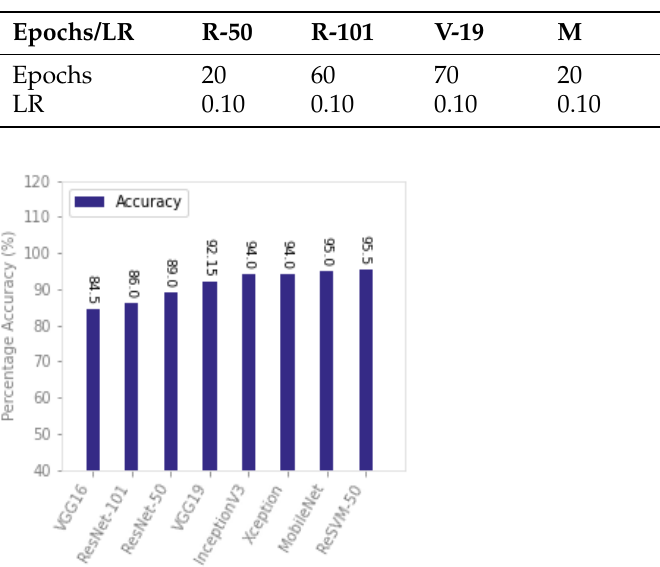
Table 3. Optimal parameters (number of epochs and learning rate) of ReSVM and state-of-the-art deep networks. R-50 = ResNet-50, R-101 = ResNet-101, V-19 = VGG-19, I-V3 = InceptionV3, M = MobileNet, Xp = Xception.